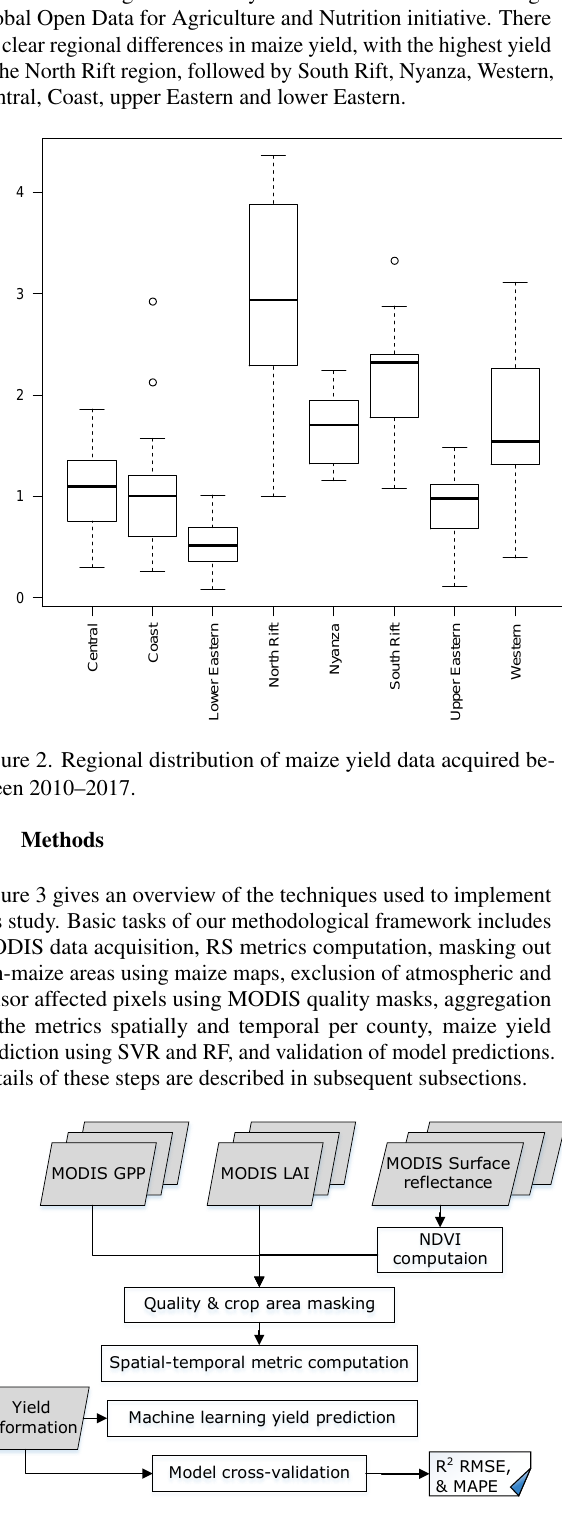
Figure 3. Methodological framework adopted for maize yield